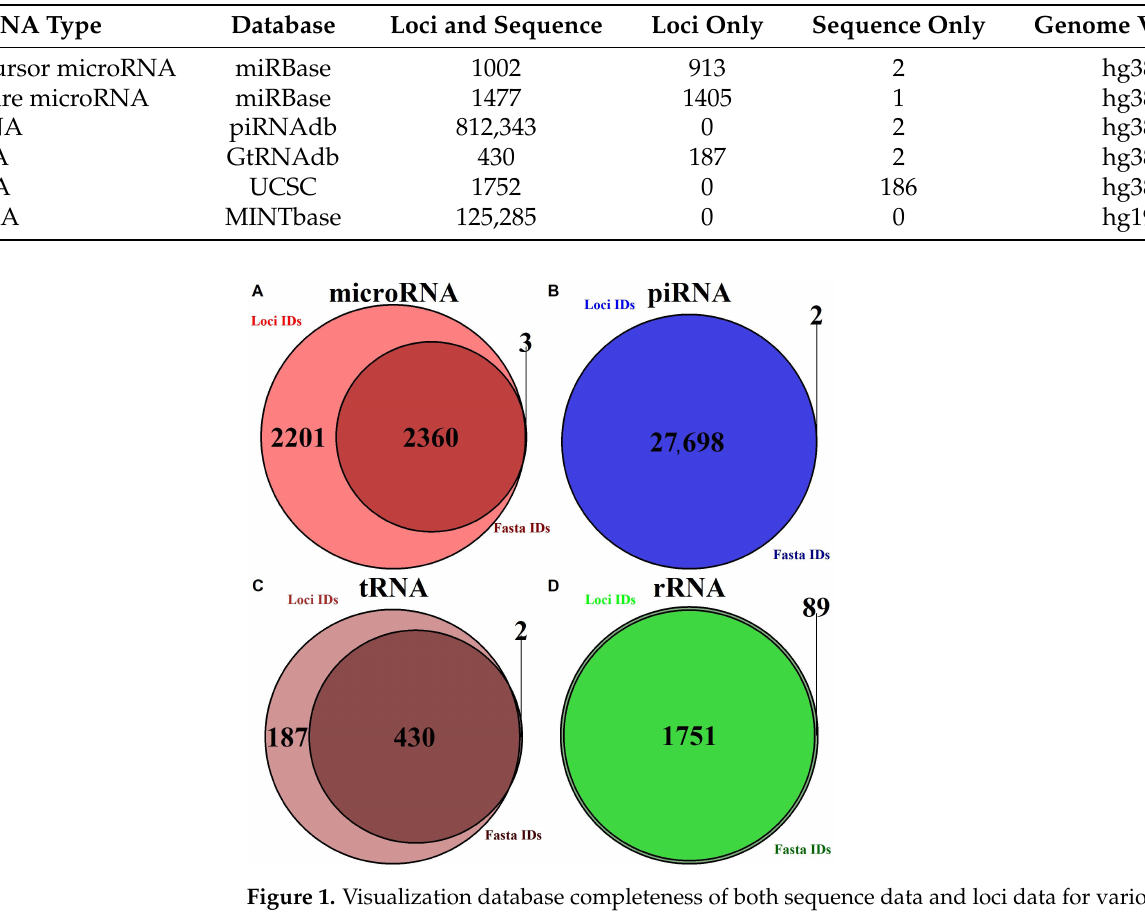
Table 1. Statistics on completeness of human small RNA transcript entries in the databases prior to any correcting or filtering.